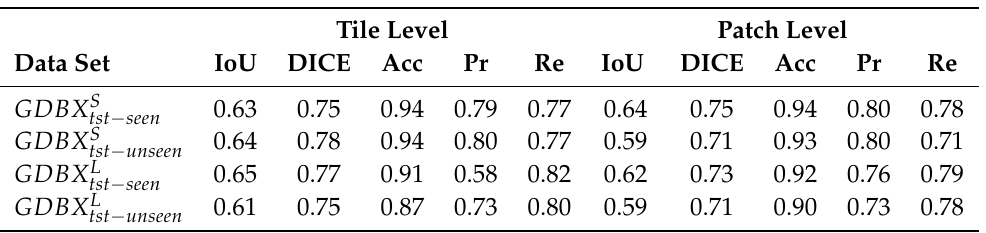
Table 10. Performance comparison of tile-level evaluation (after patch-level fusion) and patch-level evaluation (without fusion). Tile Level Patch Level Data